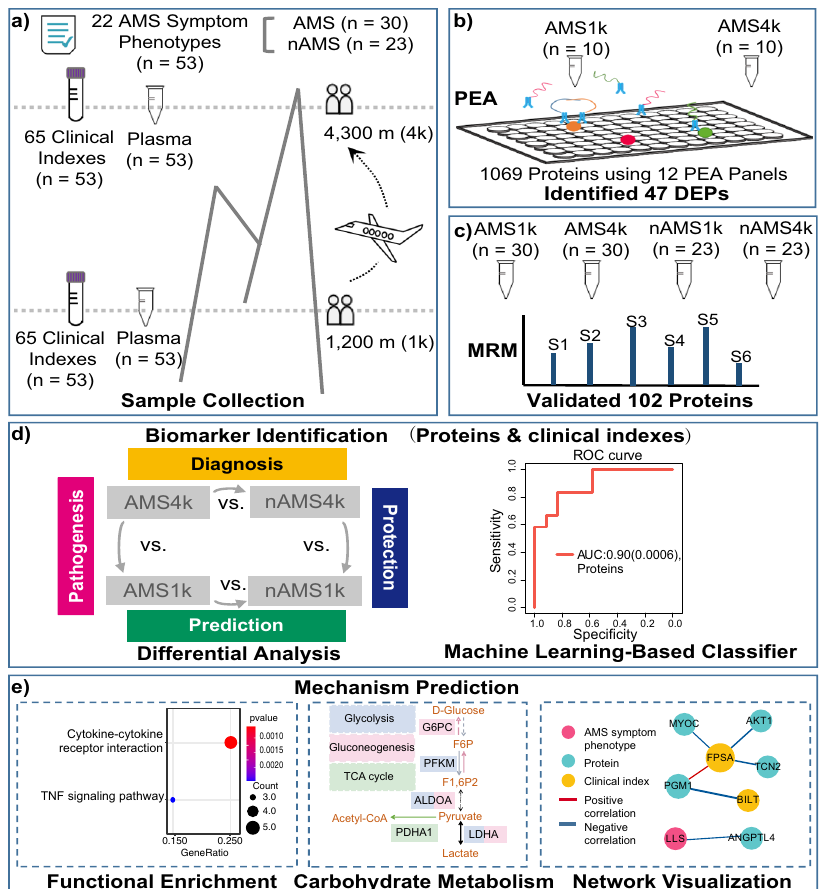
Fig. 1 Study design. a Sample collection. We recruited 53 subjects, collected plasma samples and recorded clinical indexes at low altitudes (1 km) and high altitudes (4 km), and recorded 22 AMS symptom phenotypes at high altitude. According to the Louise Lake Score, the participants were separated into 30 individuals with AMS (AMS) and 23 individuals without AMS (nAMS). b At the discovery stage, proximity extension assay (PEA) technology identi fi ed 47 plasma differentially expressed proteins (DEPs) between the ten AMS4k and ten AMS1k samples. c At the validation stage, multiple reaction monitoring (MRM) technology validated 102 proteins in four groups of samples (AMS1k: n = 30, AMS4k: n = 30, nAMS1k: n = 23, nAMS4k: n = 23). d Differential analysis and machine learning-based classi fi ers with proteins and/or clinical indexes were used in the pathogenesis (pink background, comparison between the AMS4k and AMS1k groups), protection (dark blue background, comparison between the nAMS4k and AMS1k groups), prediction (dark green background, comparison between the AMS1k and nAMS1k groups), and diagnosis (yellow background, comparison between the AMS4k and nAMS4k groups) comparisons. e Functional enrichment analysis and network analysis were performed to illustrate the